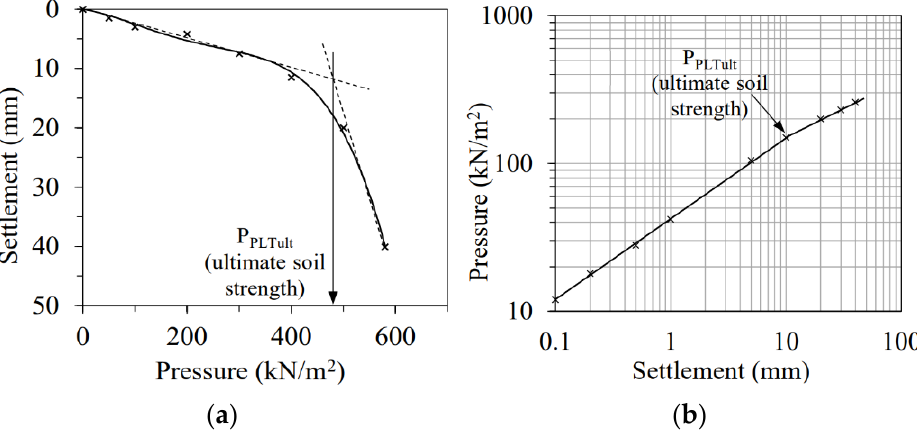
Figure 7. Load–settlement curve from PLT: ( a ) shape of curvature and ( b ) log-log plot (AbdelSalam et al., 2020).